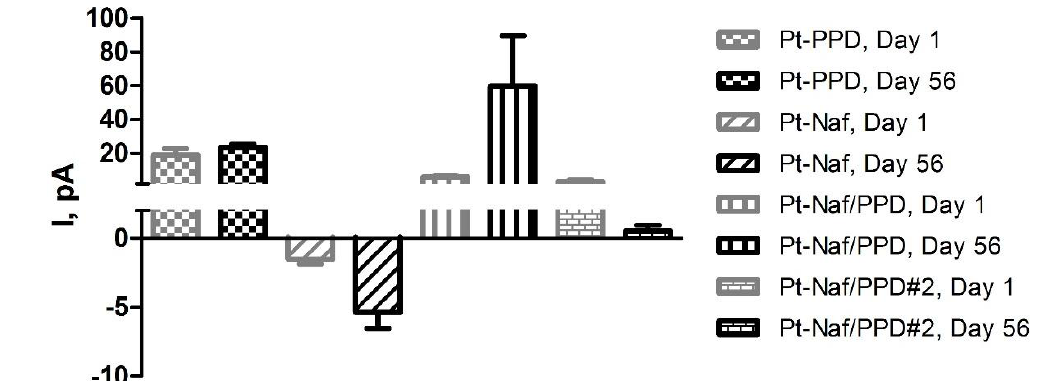
Figure 5. Effect of a single calibration on the shelf life of various Pt electrodes (Pt-PPD, Pt-Nafion ® (5/2), Pt-Nafion ® (1/2)-PPD, and Pt-Nafion ® (2/1)-PPD. Data represents maximum current recorded at 1000 μM AA for each electrode type ( n = 4).